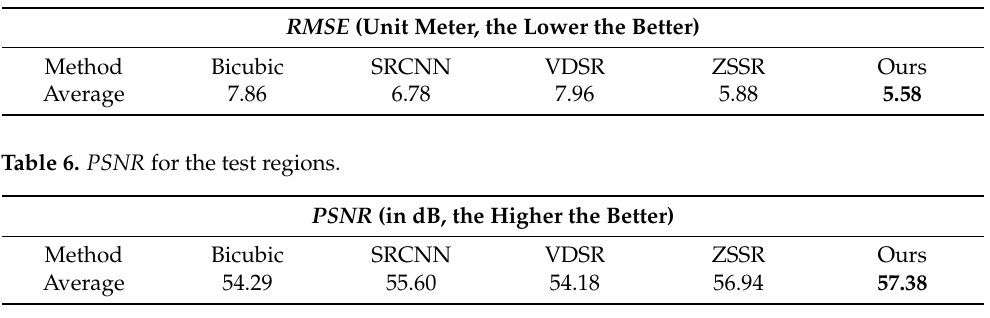
Table 5. RMSE for the test regions.